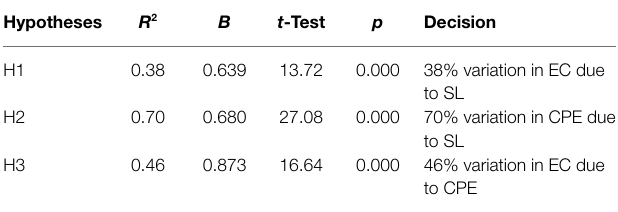
TABLE 4 | Path analysis (direct relationship).